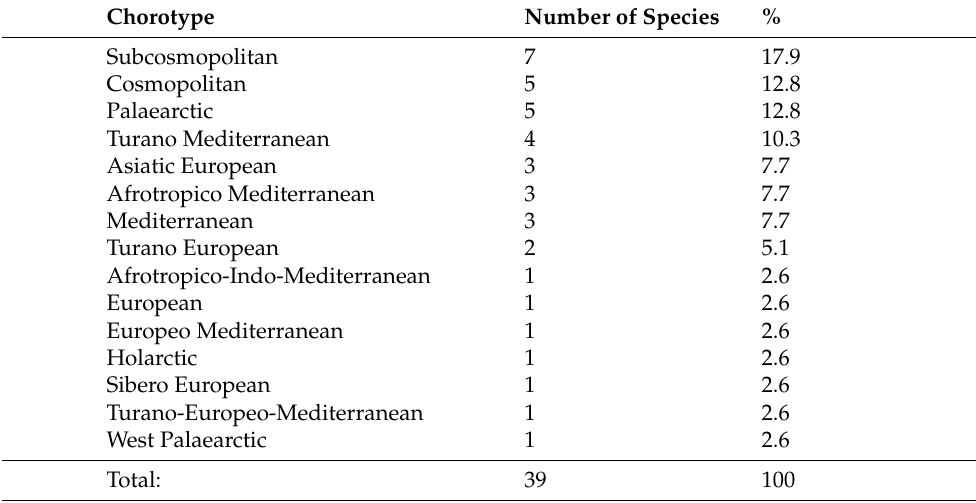
Table 2. Proportion of chorotypes for the Terebrantia of the Maltese